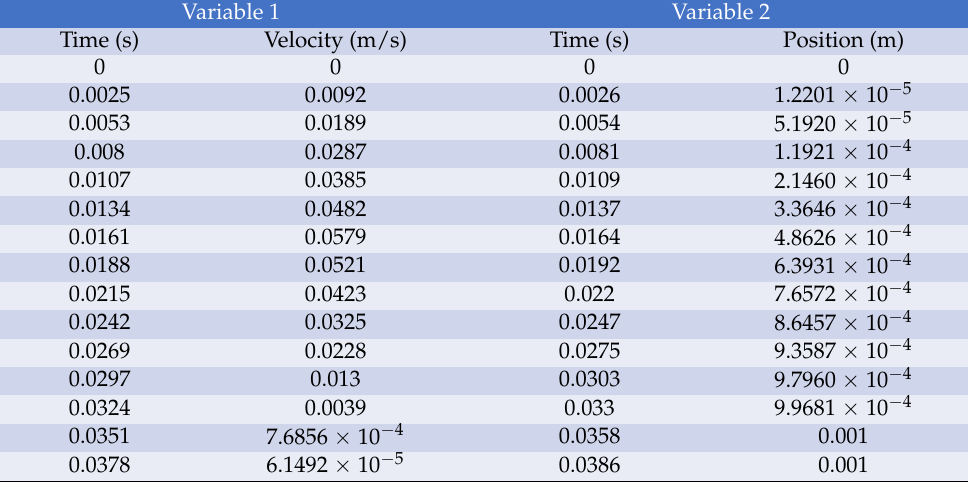
Table 1. Data output from the MATLAB